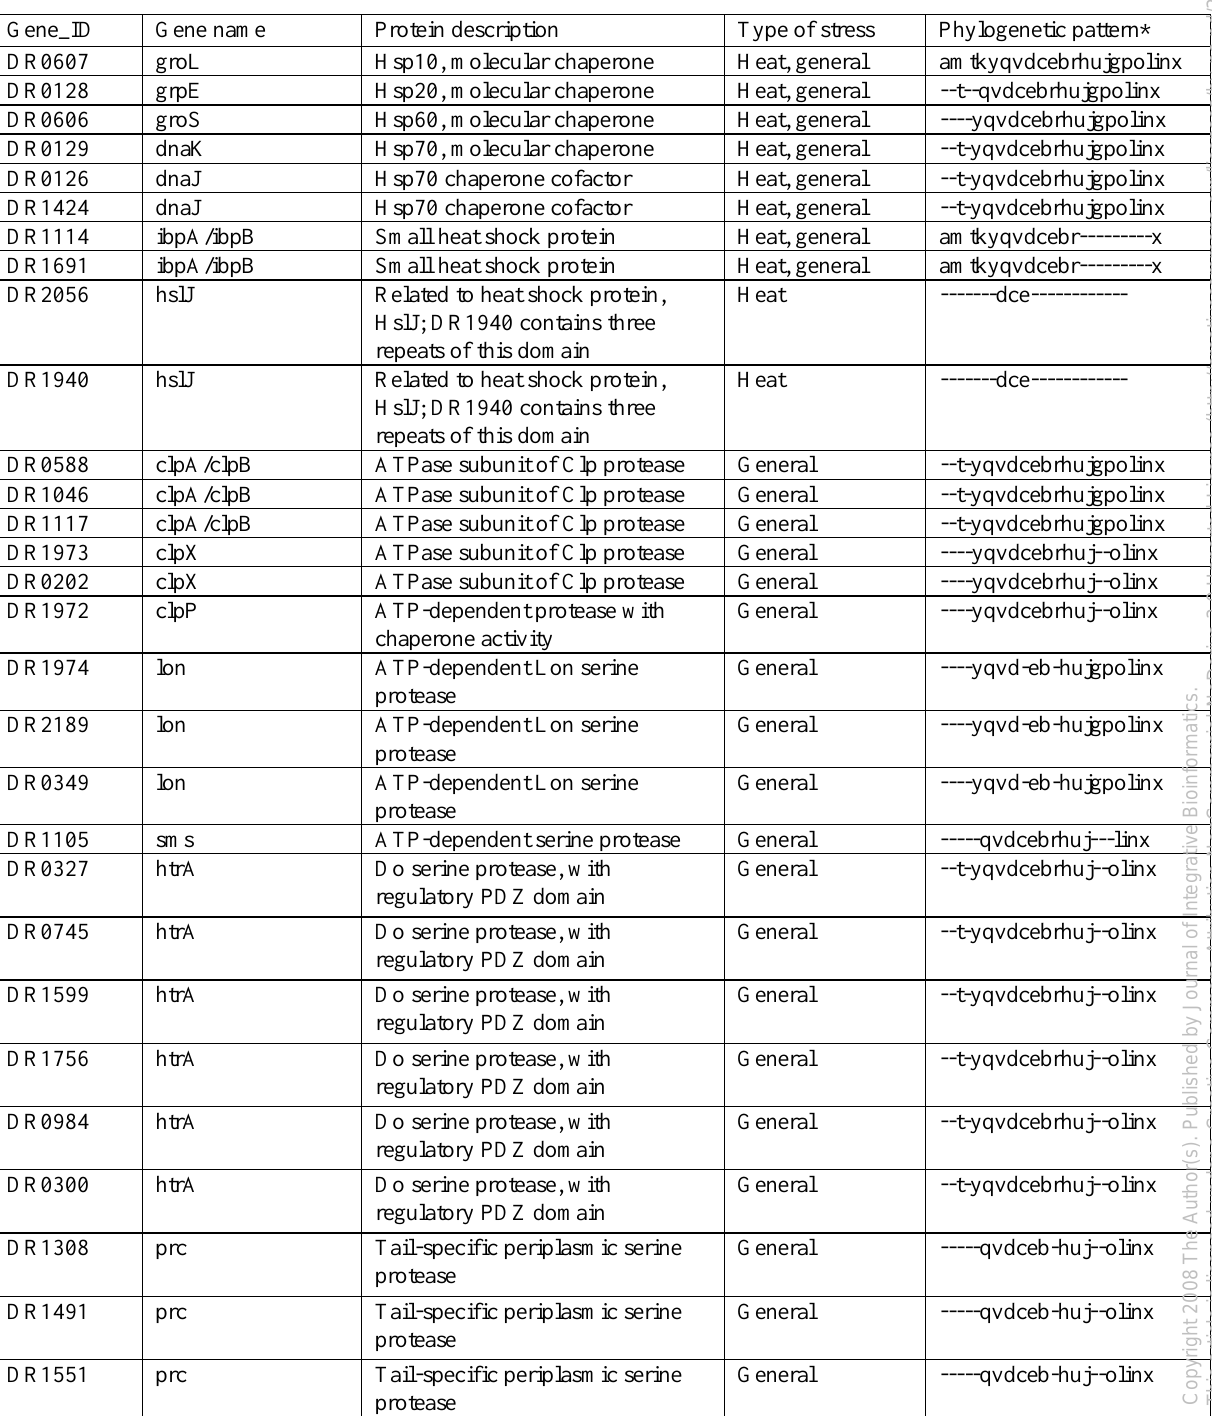
Supplementary Table 7 (S7): List of D. radiodurans genes related to stress response with their phylogenetic pattern and type of